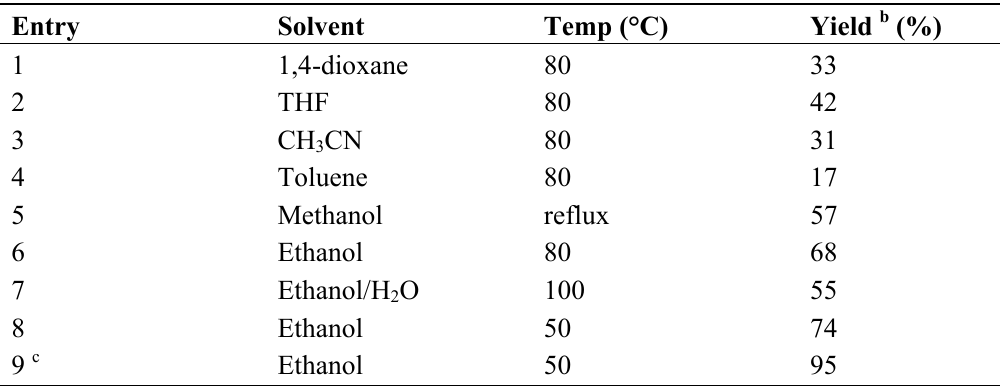
Table 1. Optimization of reaction conditions a